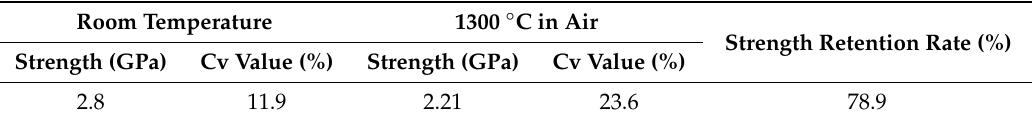
Table 2. Tensile strength of the SiC fiber at high temperature.